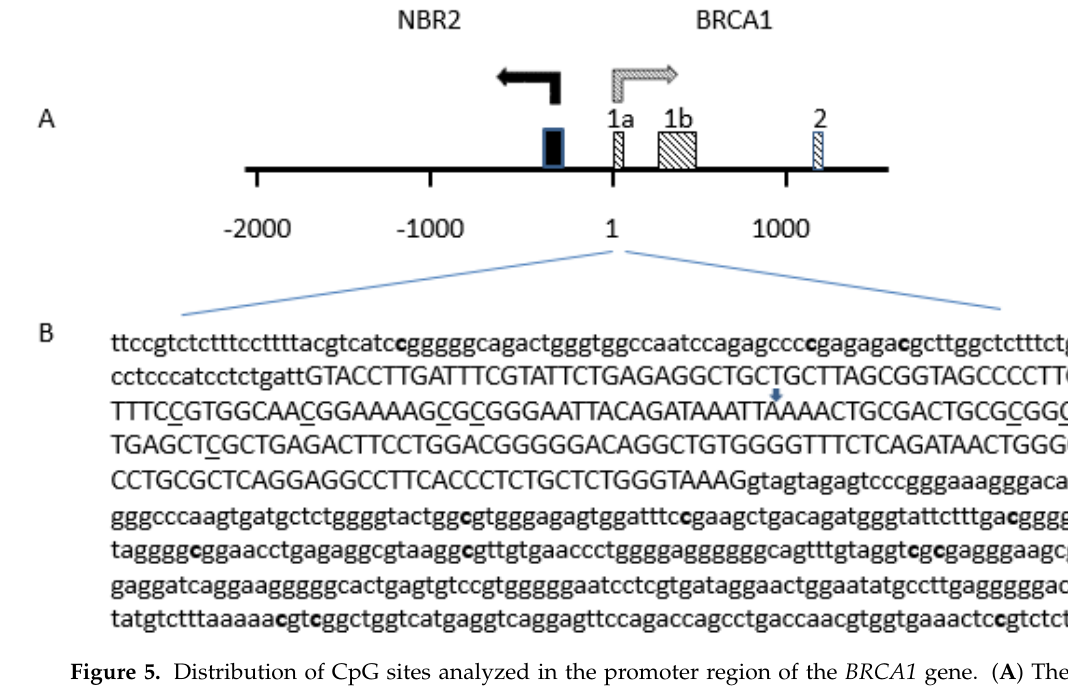
Figure 5. Distribution of CpG sites analyzed in the promoter region of the BRCA1 gene. ( A ) The BRCA1–NBR2 locus: the position of the first exons of the BRCA1 is indicated by shaded boxes. The first exon of NBR2 gene is indicated by a black box. ( B ) Position of CpG sites analyzed Cytosine on CpG sites tested by MS-PCR are underlined. Cytosine on CpG sites tested by MassARRAY® EpiTYPER® assay are in bold. The positive strand of the BRCA1 gene is shown based on GenBank accession number U37574. The transcription start site of the BRCA1 exon 1A is marked by an arrow. Exon 1A sequence is in capital, and both 5’upstream sequence and intron 1 sequence are in lower case